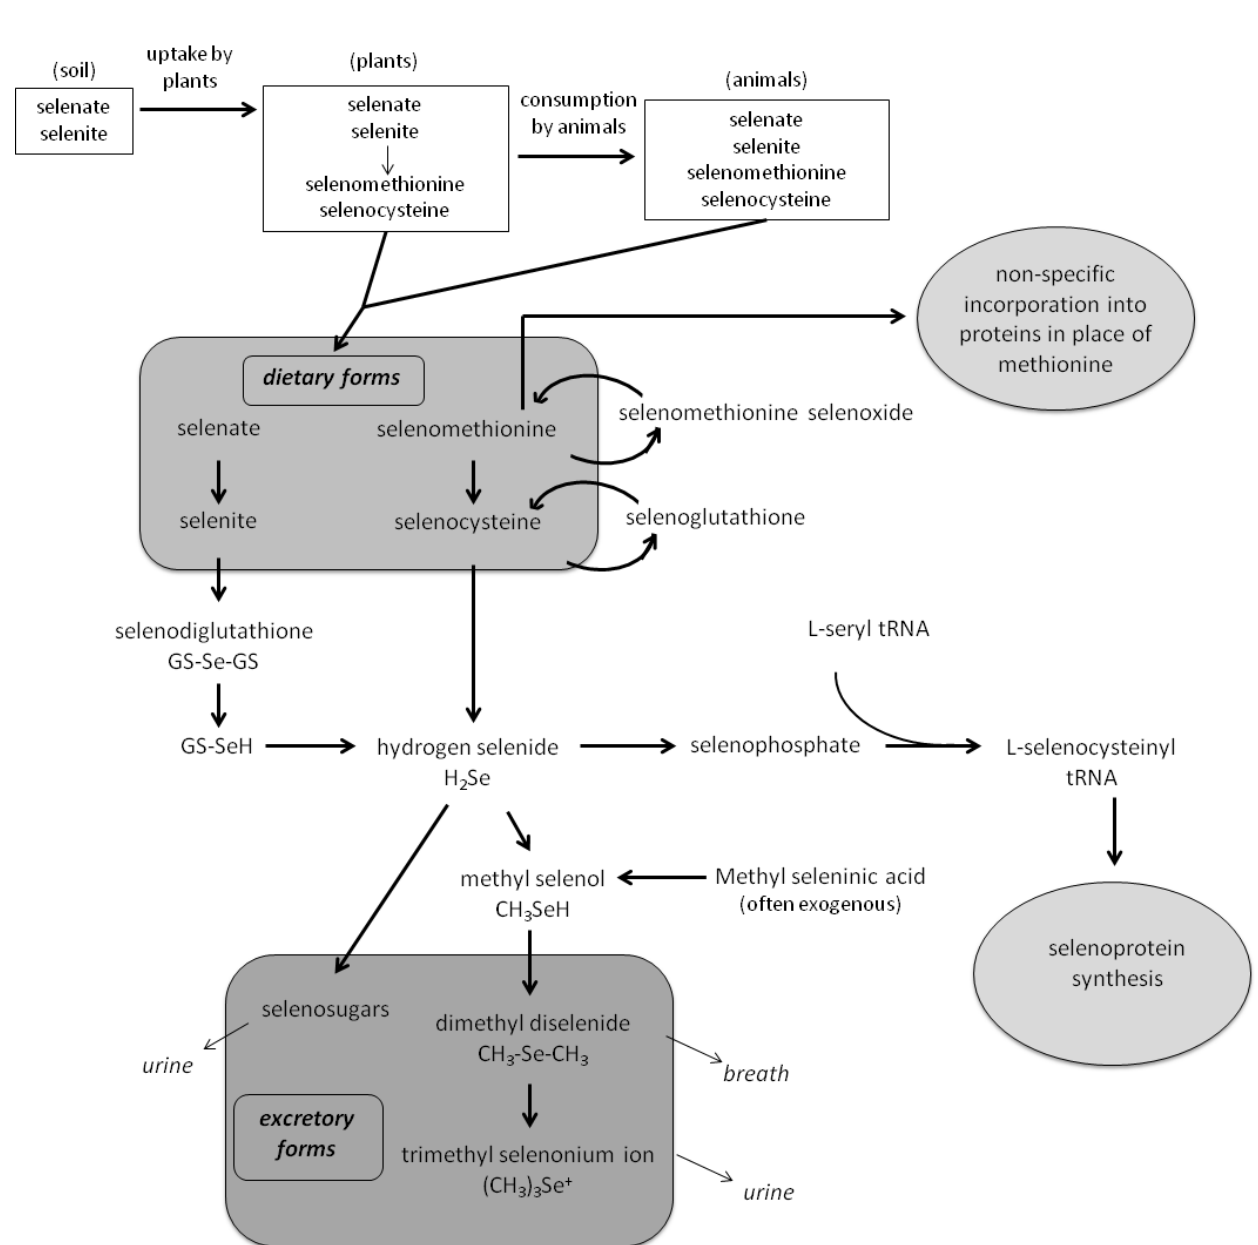
Figure 1. Selenium